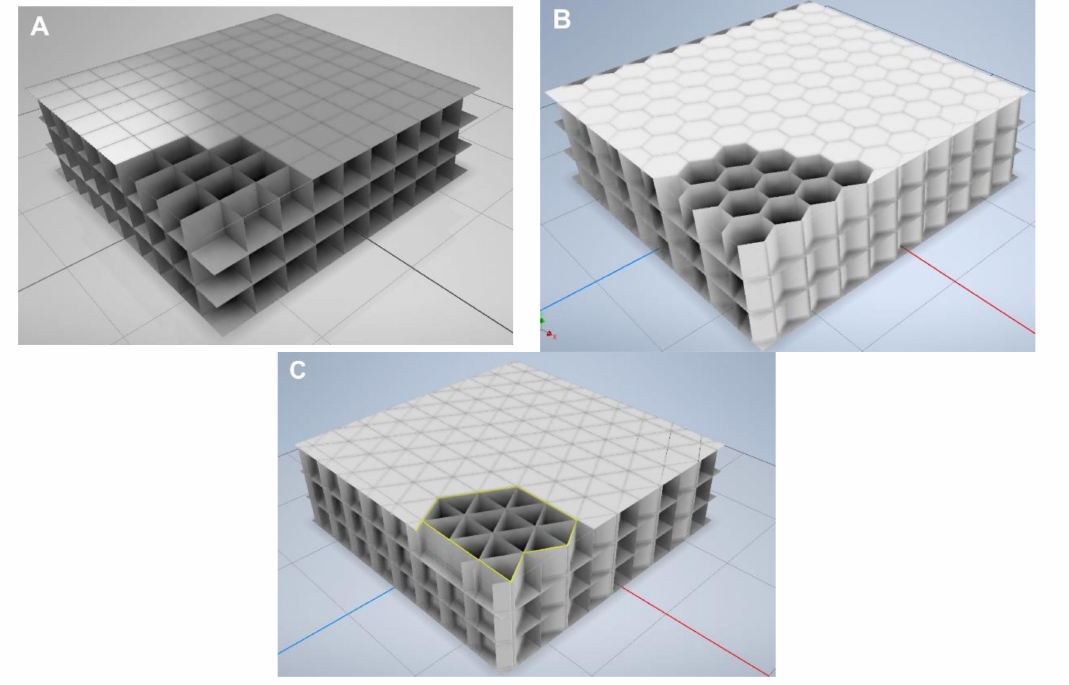
Figure 2. Design of air partitions with di ff erent regular closures. ( A ) square shape, ( B ) hexagonal shape, ( C ) triangular